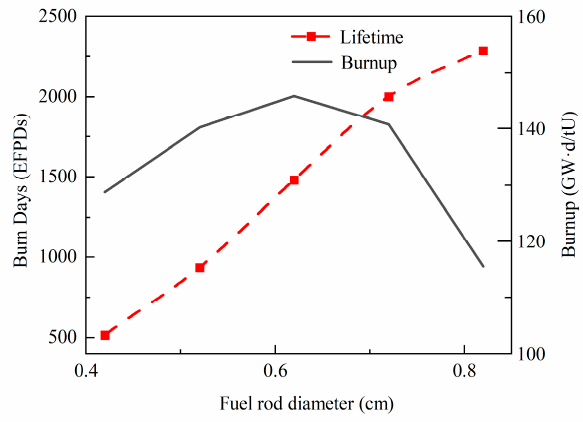
Figure 11. Fuel burnup characteristics at different fuel rod diameters.